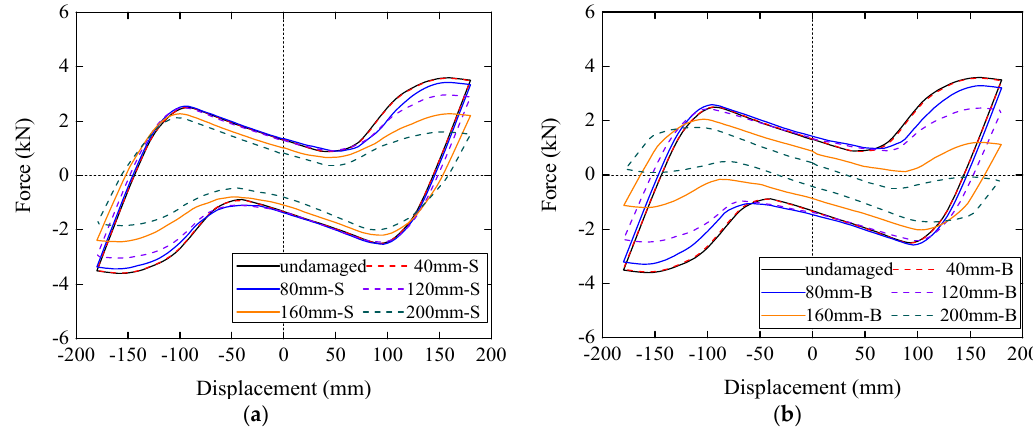
Figure 26. Hysteresis curves of last cycle: ( a ) Single tenon damaged; ( b ) both tenons damaged.